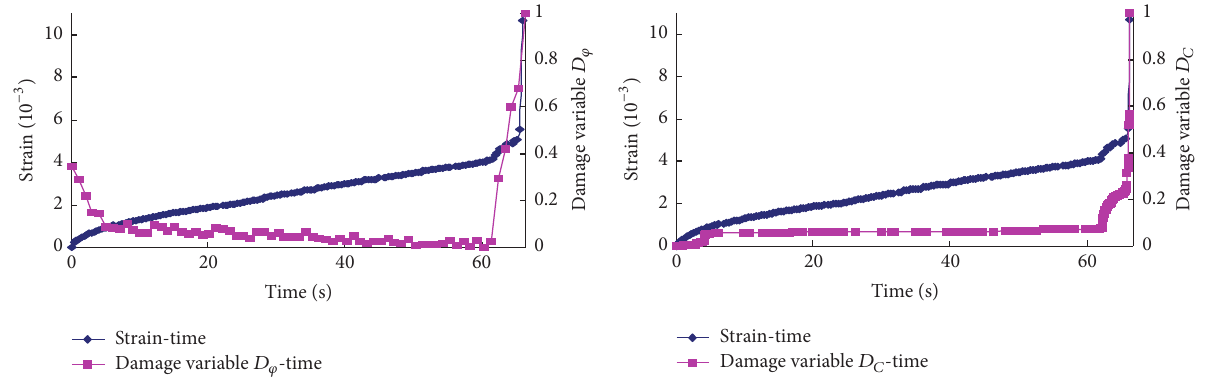
(a) Time-varying curve of the damage variable based on the electrical resistivity Figure 6: Damage variable-time curve of samples whose loading directions are vertical to the bedding plane.